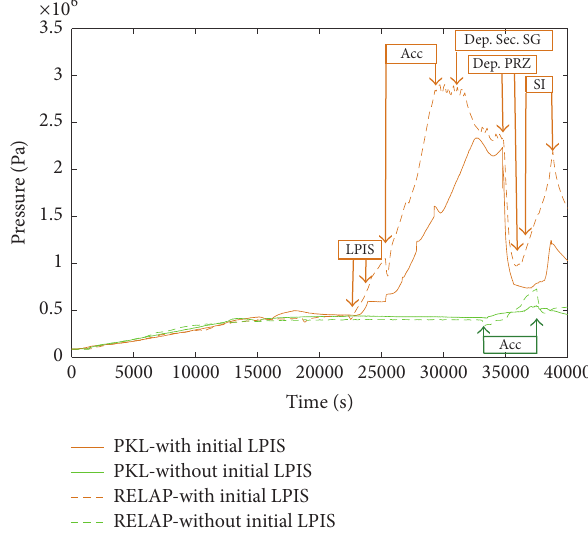
Figure 6: Pressure. PKL versus RELAP5. Injections and depressur- ization (Phase II).